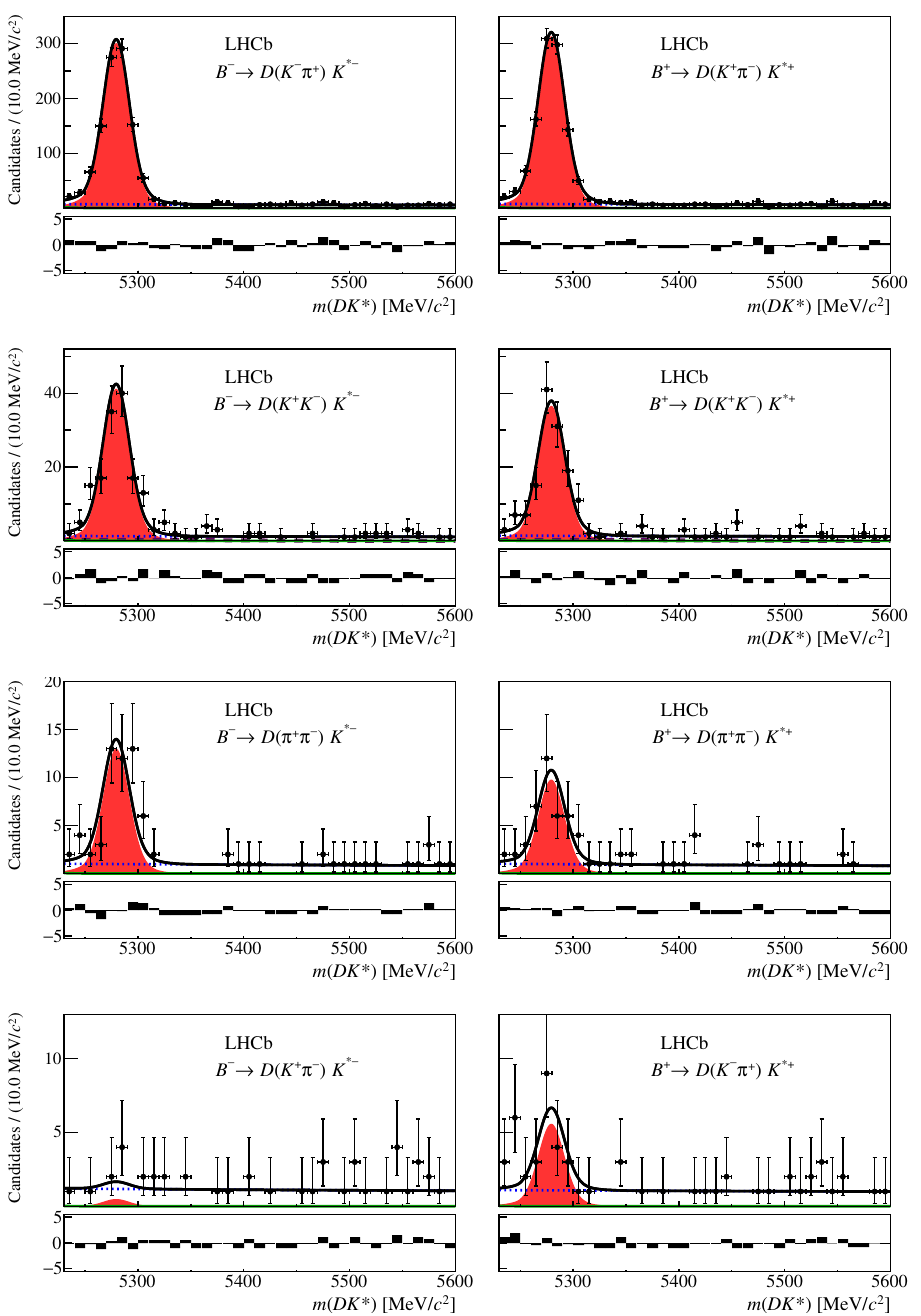
Figure 2. Result of (cid:12)ts to data for the two-body decay modes with Run 1, Run 2, long and down- stream categories summed for presentation. The signal is represented by the red shaded area, the combinatorial background by the dotted blue line and the partially reconstructed background by the solid green line. In the D 0 ! K + K (cid:0) (cid:12)ts the (cid:3) 0 ! (cid:3) + K (cid:3)(cid:0) background is represented by the dashed c b purple line. The total (cid:12)t is given by the black line. The residuals, shown below each plot, are de(cid:12)ned as the di(cid:11)erence between the data and the (cid:12)t value in each bin, normalised by the uncertainty.